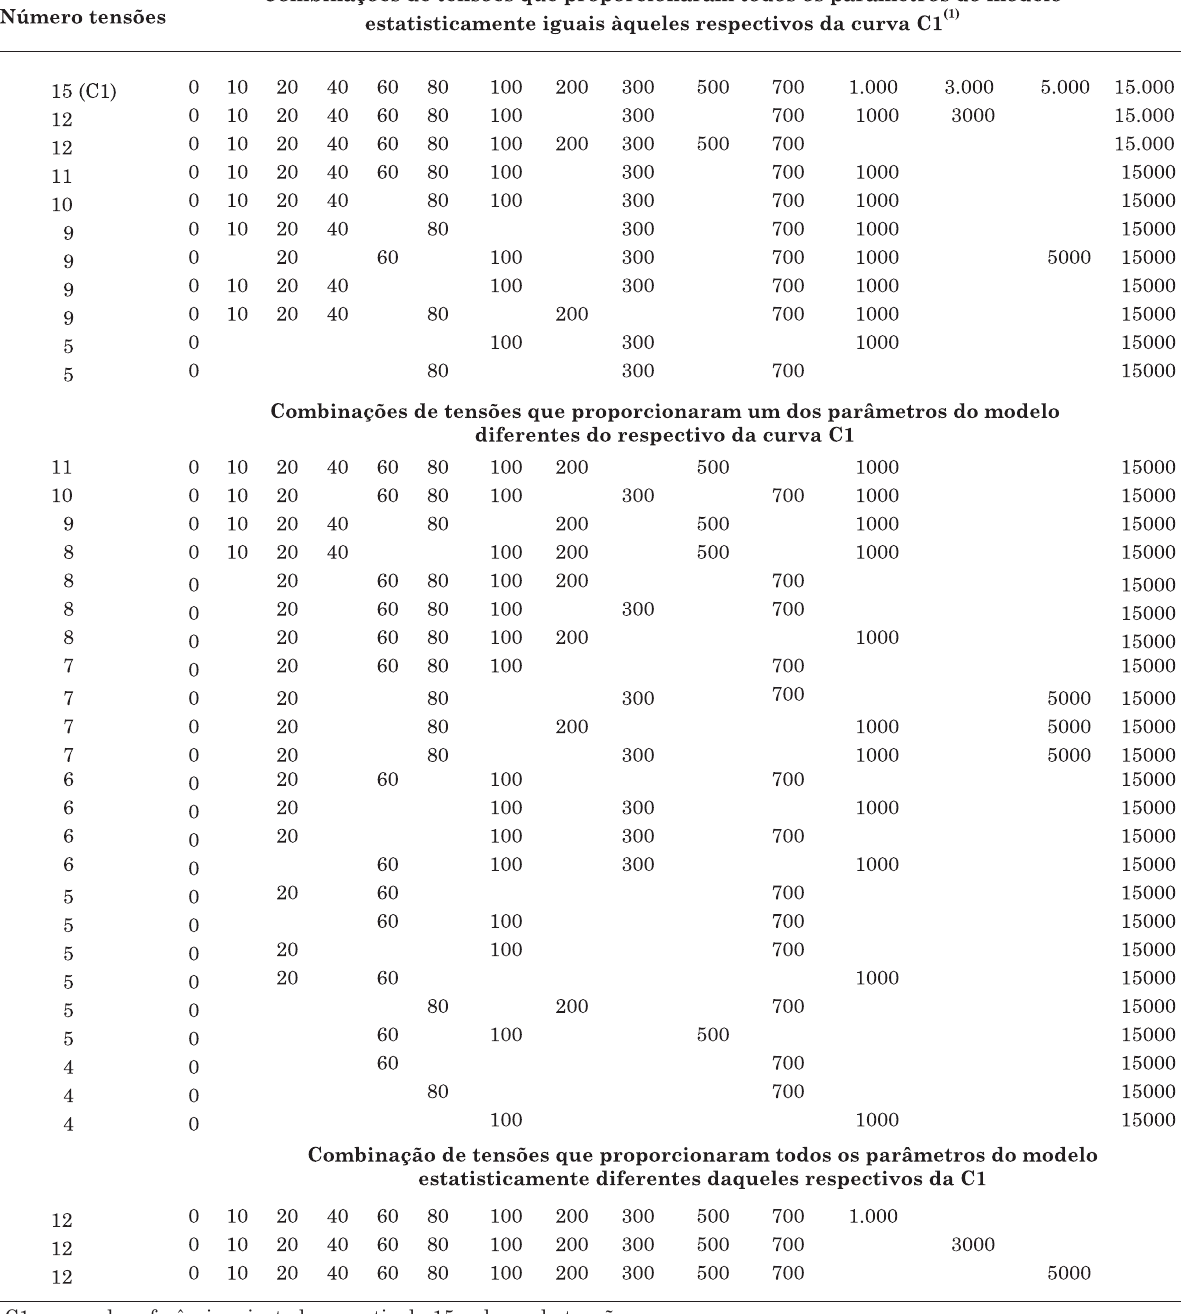
Quadro 4. Combinações de tensões utilizadas no modelo de van Genuchten (1980), as quais geraram